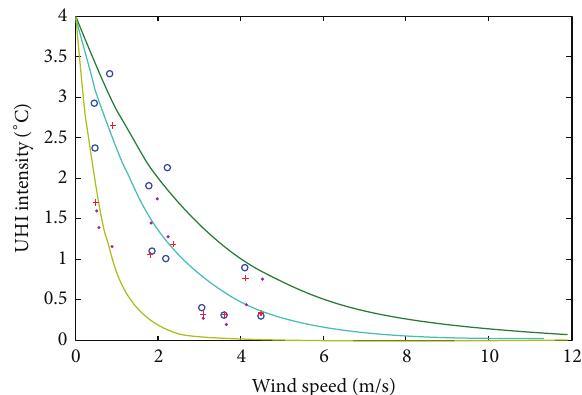
Figure 6: The effects of wind speed on UHI intensity for St. Cesaire, St. Pie, and Ste. Angele-de